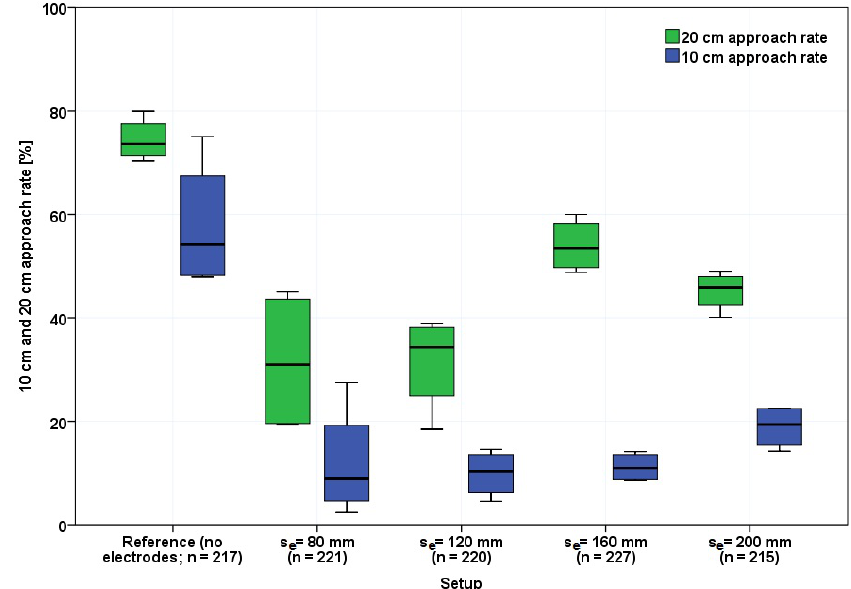
Figure 6. Approach rates [%] based on the number of participations in all setups (each N = 4). Boxplots include representative statistic measures: minimum, first quartile, median, third quartile and maximum. Number of participating individuals per setup and four trials (N = 4) is denoted as